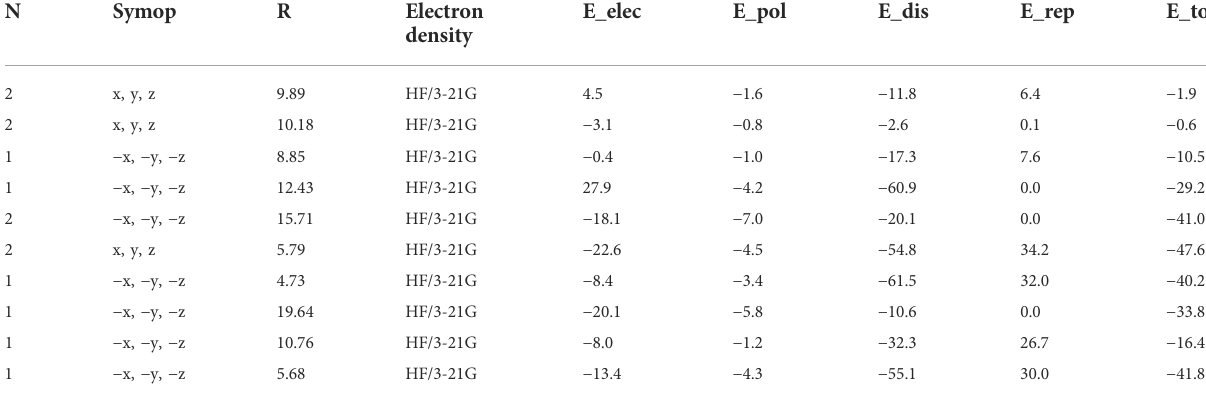
TABLE 4 Interaction energies (kJ mol − 1 ) calculated for isomaleimide